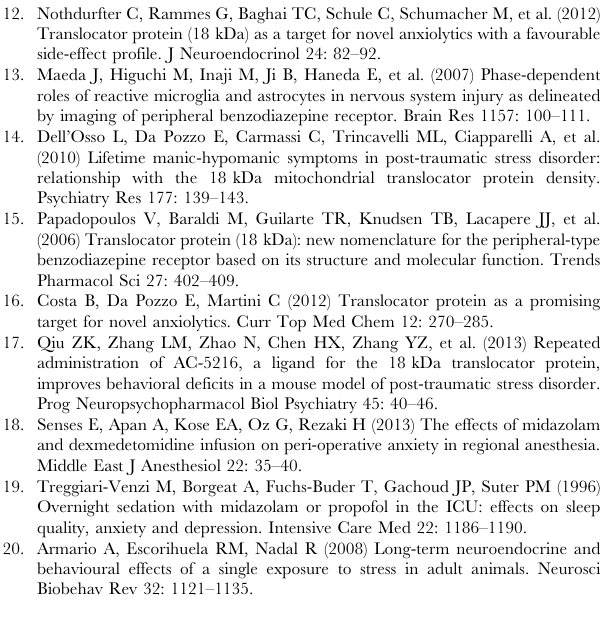
Figure 4. The anxiolytic-like effects of repeated midazolam treatment and the antagonistic effects of PK11195, flumezenil or finasteride in SPS-exposed rats as measured by percentages of time spent in (A, E, I, M) and entries into (B, F, J, N) the open arms of the EPM, total time spent in the arms (C, G, K, O), and total arm entries (D, H, L, P), respectively. ## p , 0.01 vs. vehicle-treated foot shock ( 2 ) group; * p , 0.05, ** p , 0.01 vs. vehicle-treated foot shock ( + ) group; $ p , 0.05 vs. midazolam-treated group (0.5 mg/kg, p.o.)